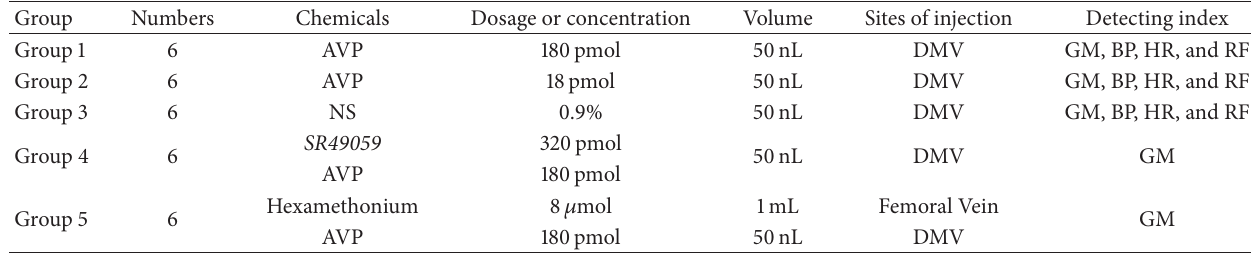
Table 1: The design of the